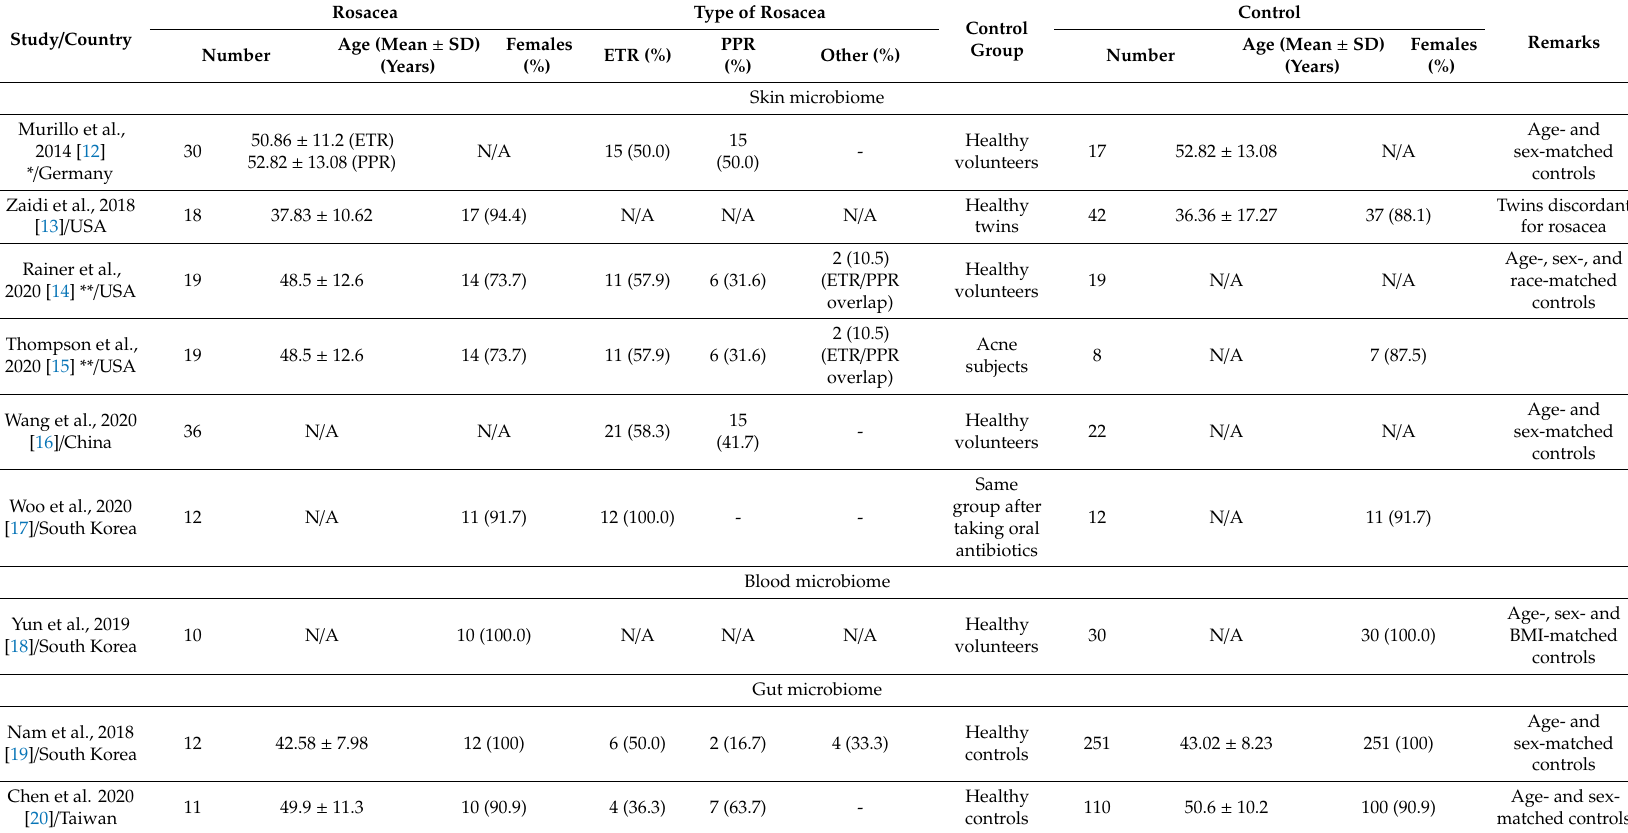
Table 1. Studies included in the